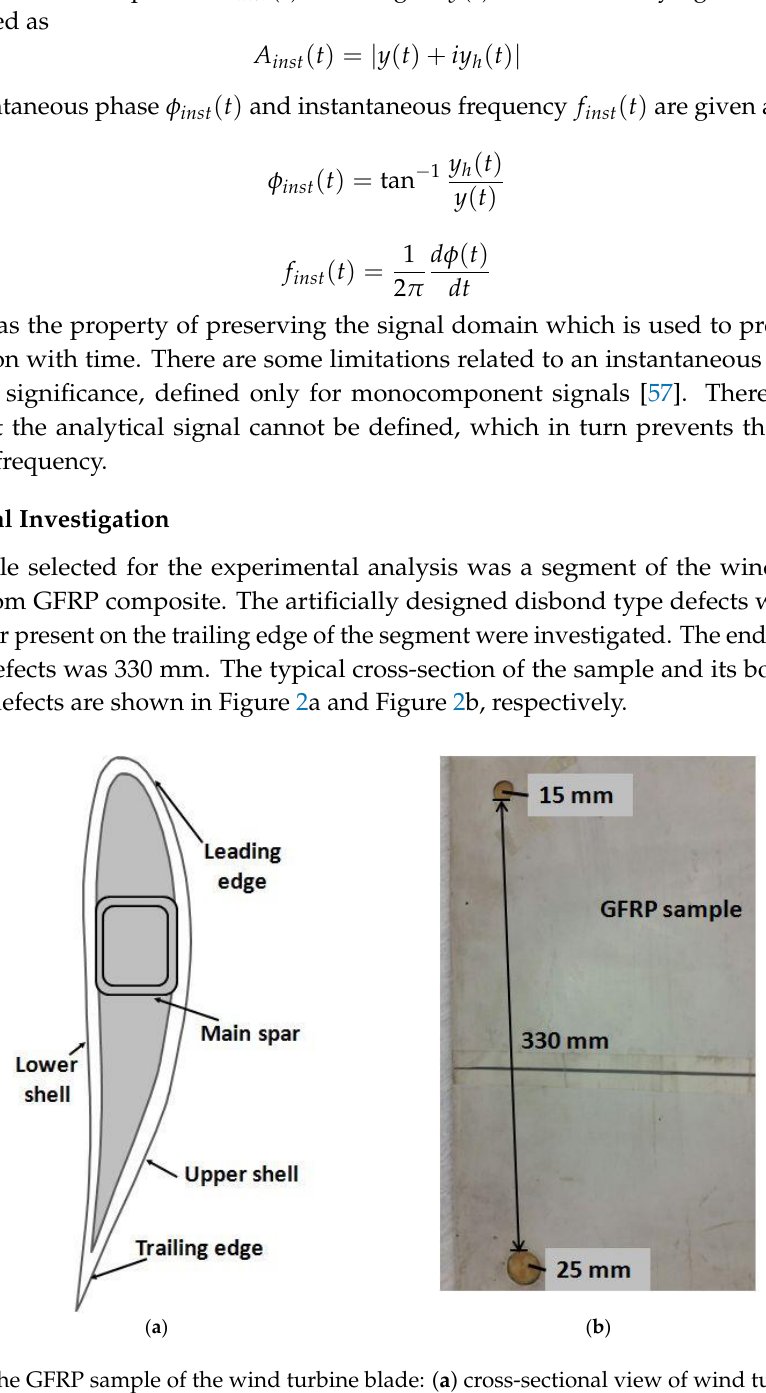
Figure 2. The GFRP sample of the wind turbine blade: ( a ) cross-sectional view of wind turbine blade; ( b ) bottom-side view of GFRP sample showing the defects of 15 mm and 25 mm diameter on the trailing edge of the sample (opposite side of scanning surface).